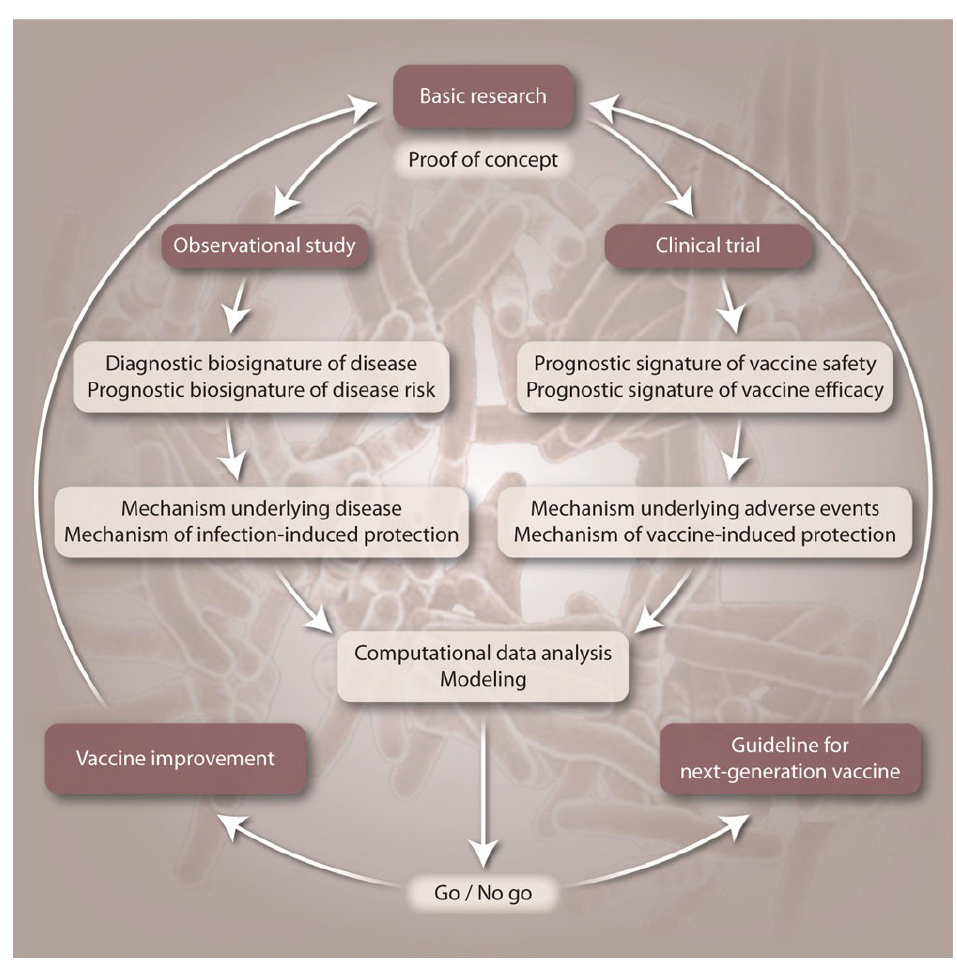
Figure 2. Role of biomarkers in TB vaccine development. This figure has been reproduced with permission from Kaufmann, Evans, Hanekom, Science Transl. Med., 2015 32